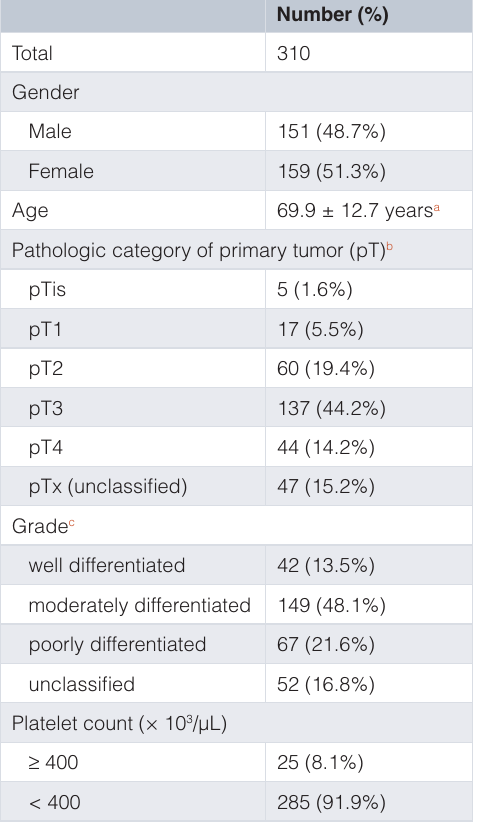
Table 1. Patient characteristics.